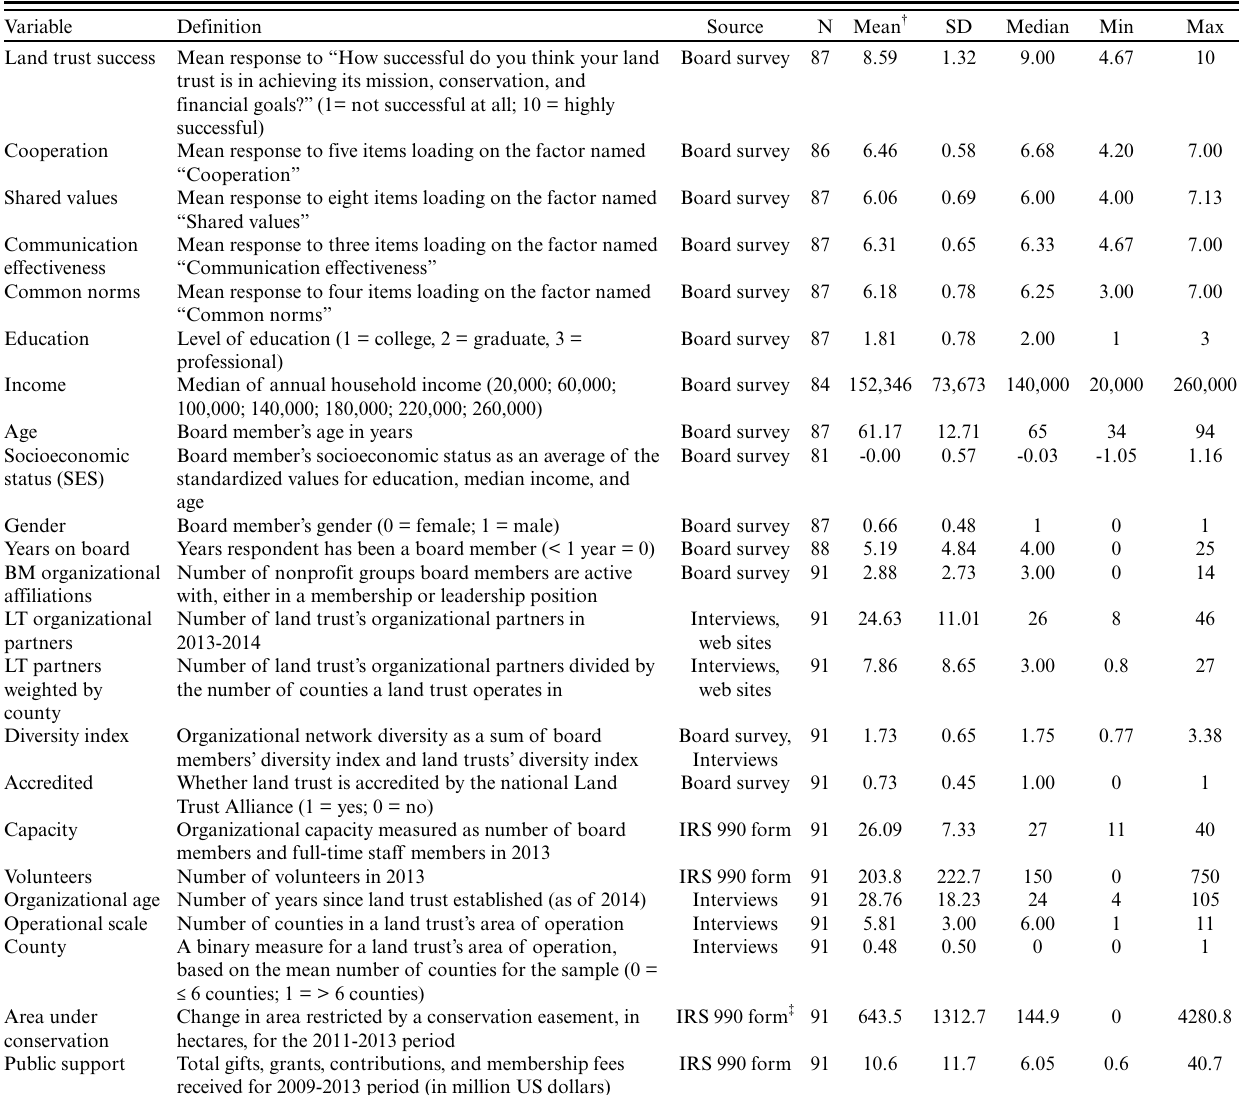
Table 3 . Definitions, data source, and descriptive statistics for variables used in the